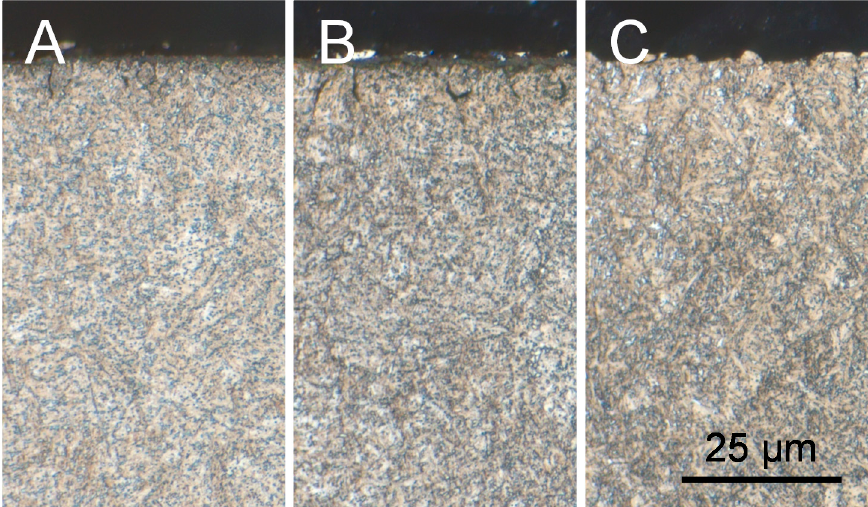
Figure 4. Cross sections of the material X38CrMoV5-3 after the carbonitriding treatments etched with Nital (for heat treatment parameters of ( A – C ) see Table 2).